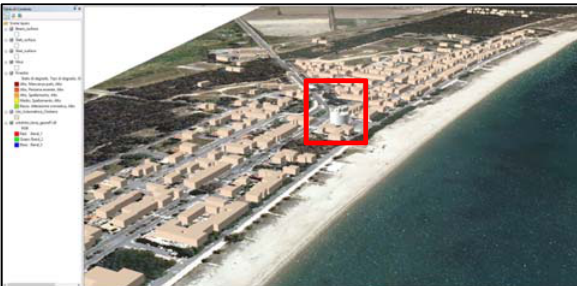
Figure 11. The parametric model in the urban